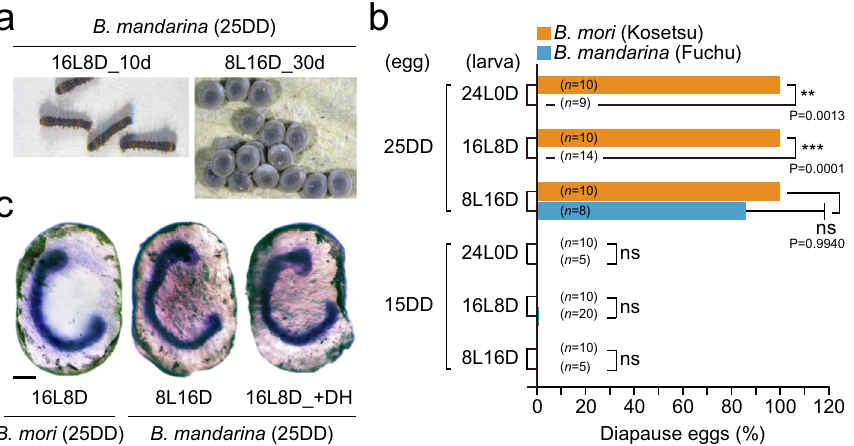
Figure 1. Temperature and photoperiodic diapause induction in Bombyx mori and B. mandarina . ( a ) The typical larvae and eggs of the wild mulberry silkworm B. mandarina . Eggs were incubated at 25DD; after that, larvae were reared at 16L8D or 8L16D. Progeny eggs hatched on 10 d after oviposition under the 16L8D condition, whereas progeny eggs never hatched by 30 d after oviposition under the 8L16D condition. ( b ) Effects of temperature and photoperiodic conditions during embryonic and larval stages on diapause egg-inducing activity in the Kosetsu strain of B. mori and a Fuchu population of B. mandarina . After eggs were incubated under the 25DD or 15DD condition, larvae were reared on 24L0, 16L8D, and 8L16D conditions. Each bar represents the mean ± SD of 5 − 20 animals. Significant differences represented in B. mori versus B. mandarina are in the same condition. ns, non-significant; **, P < 0.01; ***, P < 0.001. ( c ) Thionin staining of embryos 30 d after oviposition of domestic silkworm B. mori in 16L8D (25DD), and 30 d after oviposition of B. mandarina in both 8L16D and DH-injected silkworm in 16L8D (25DD). Scale bar = 200 µm.